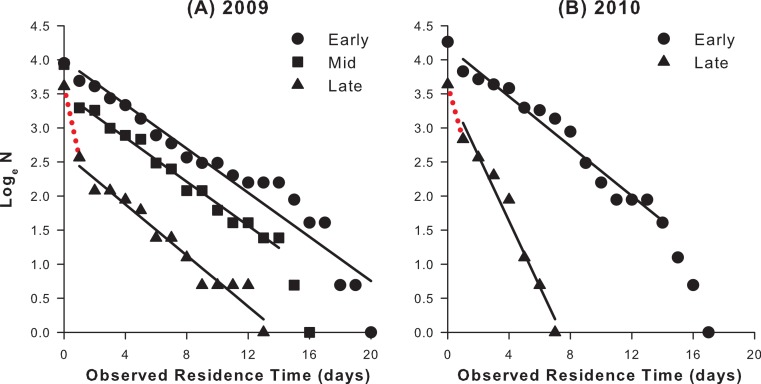
Intra-seasonal residence plots for 2009 and 2010.The residence-rate is related to the gradient (m) of the plots; the steeper the slope, the faster specimens depart (die/emigrate) from the population and the lower the residence-rate. (A) In 2009, recaptured butterflies behaved uniformly through the season (m ± SE = −0.162 ± 0.011 for early (1–12 d) specimens; −0.162 ± 0.006 for mid (13–26 d) specimens; −0.187 ± 0.012 for late (27–46 d) specimens); therefore the low number of late season recaptures must be attributed to the appearance of a new phenotype which evaded recapture due to a high death/emigration rate (red dotted line). (B) In 2010, recaptured late season butterflies exited the population more quickly than early season ones (m ± SE = −0.182 ± 0.010 for early (1–21 d) specimens; −0.480 ± 0.041 for late (22–36 d) specimens); this was sufficient to account for the low number of recaptures during that period (red dotted line). In this case, the behaviour of the average phenotype had changed through the season. Compare Fig. 3.